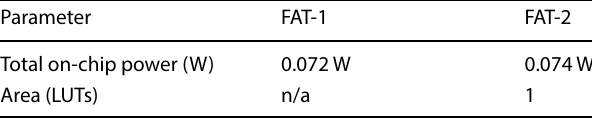
Table 5 Synthesis results of the implemented TRNG based on